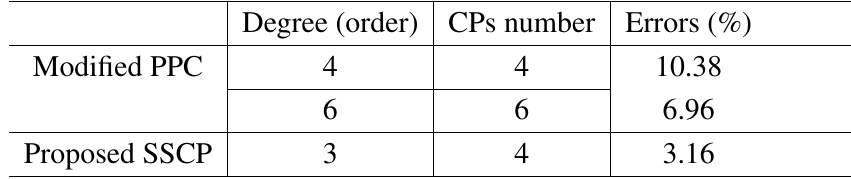
Table 3. Comparison results with modified PPC.